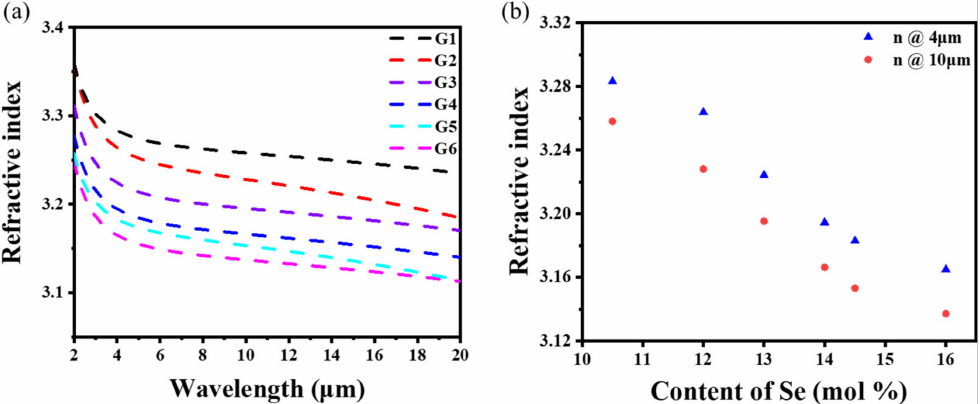
Figure 3. ( a ) Dependence of the refractive index of the Ge 17.2 As 17.2 Se x Te (65 − x ) glasses on the wave- length; ( b ) the relationship between the refractive index and Se